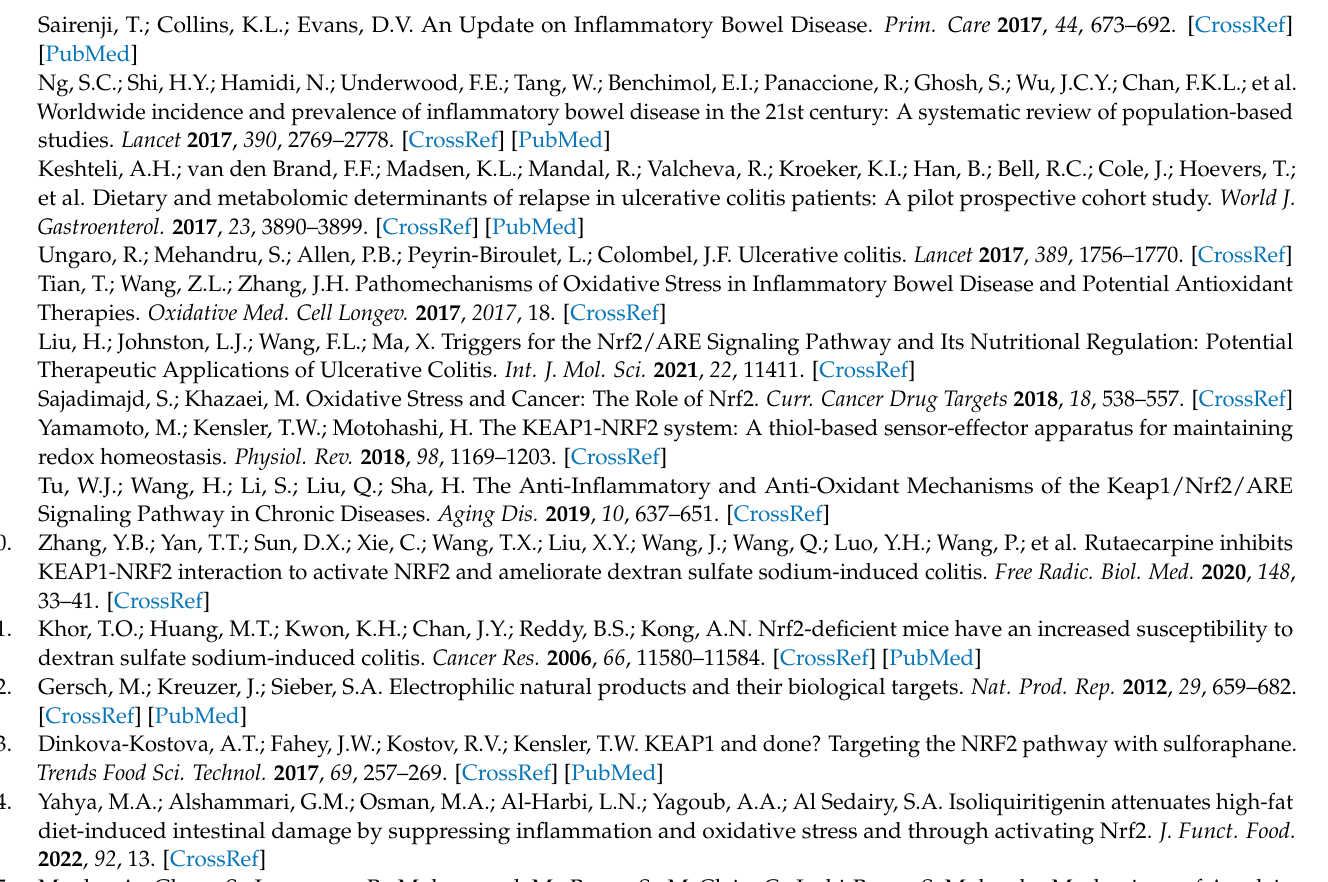
colon. Figure S4: Correlation analysis between molecular characteristic values of FECs and the protein expression levels of Nrf2, NQO1 and HO-1 in